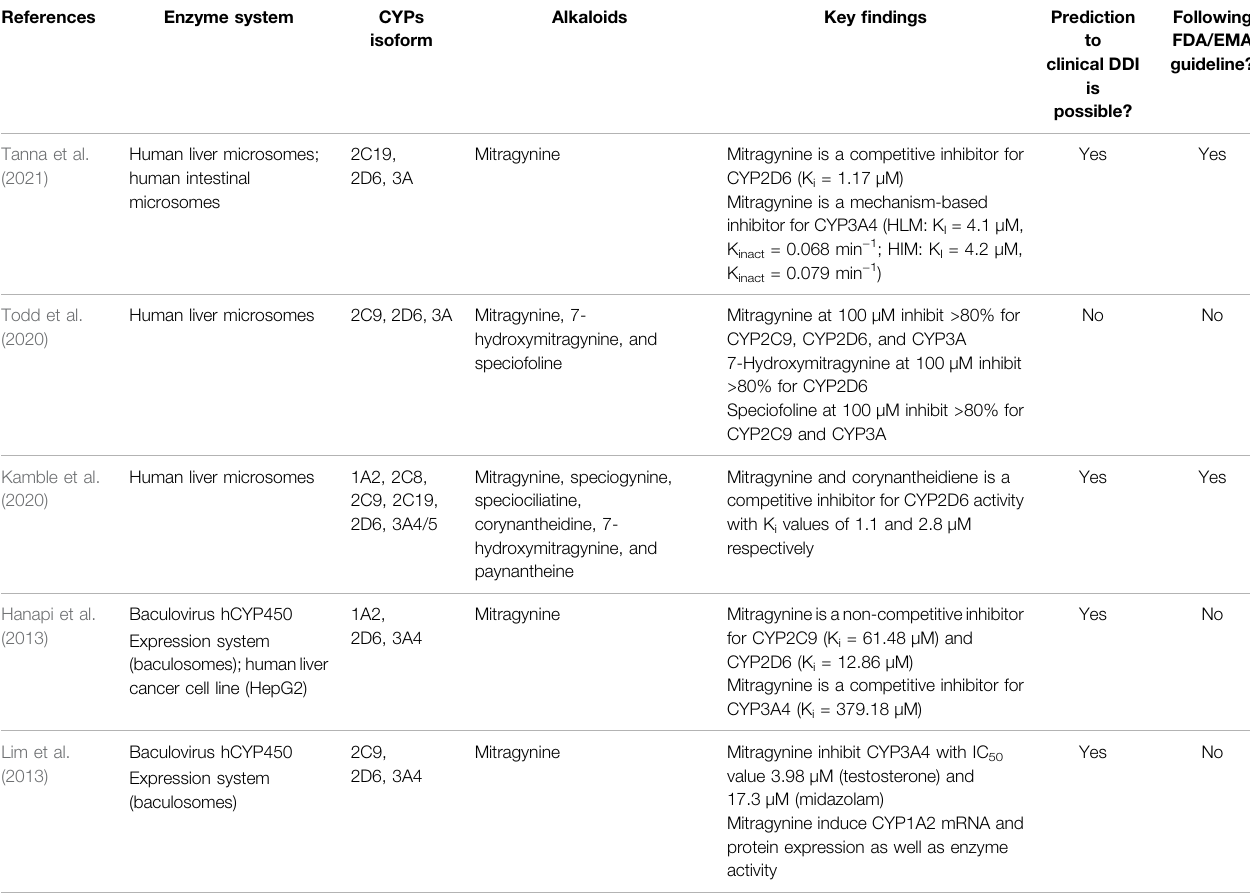
TABLE 2 | Extent of mitragynine and related alkaloids inhibition on major human drug metabolizing enzymes